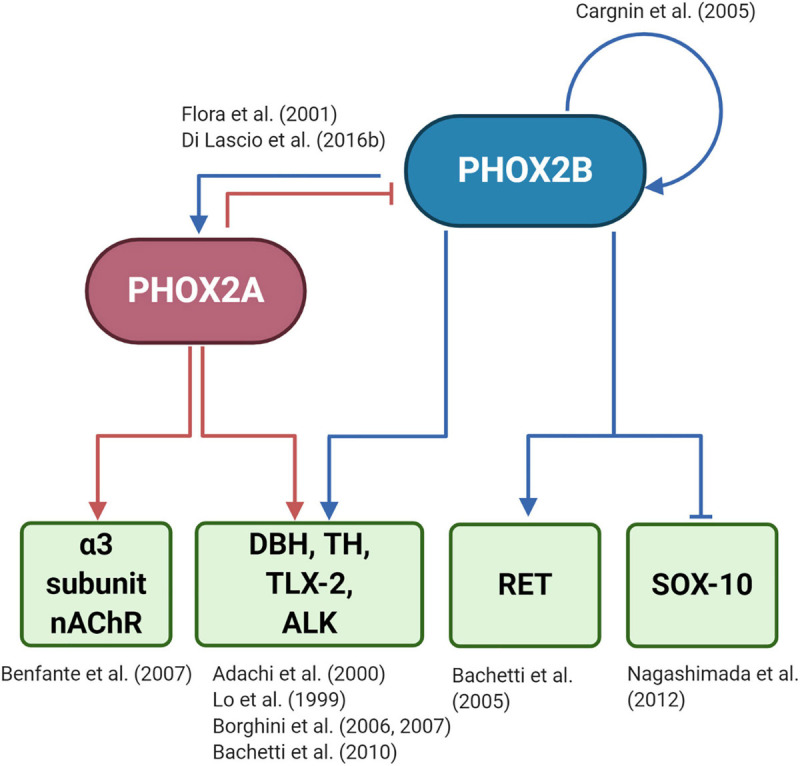
(Created with BioRender.com) Target genes regulated by PHOX2B and PHOX2A. The diagram shows that PHOX2B regulates itself (Cargnin et al., 2005). Expression of the paralog gene PHOX2A, which is important for the expression of pan-autonomic genes as the α3 subunit of the ganglionic type nAChR (Benfante et al., 2007), depends on PHOX2B (Flora et al., 2001). PHOX2A, in turn, negatively regulates PHOX2B (Di Lascio et al., 2016b). Tyrosine hydroxylase (TH) and Dopamine-Beta-Hydroxylase (DBH), the rate-limiting enzymes of catecholamine biosynthesis (Lo et al., 1999; Adachi et al., 2000), TLX-2 (Borghini et al., 2006, 2007), a transcription factor involved in the development of enteric nervous sytem, and ALK (Bachetti et al., 2010), a tyrosine kinase whose mutations are associated with neuroblastoma, are regulated by both PHOX2 proteins. RET that is the most important gene driving the complex inheritance of Hirschsprung’s disease (HSCR), is indirectly regulated by PHOX2B (Bachetti et al., 2005), as RET promoter does not contain a PHOX2B responsive element. The inhibition of SOX10 by PHOX2B is critical for the differentiation of bipotential neural crest derived progenitors toward neuronal lineage (Nagashimada et al., 2012).